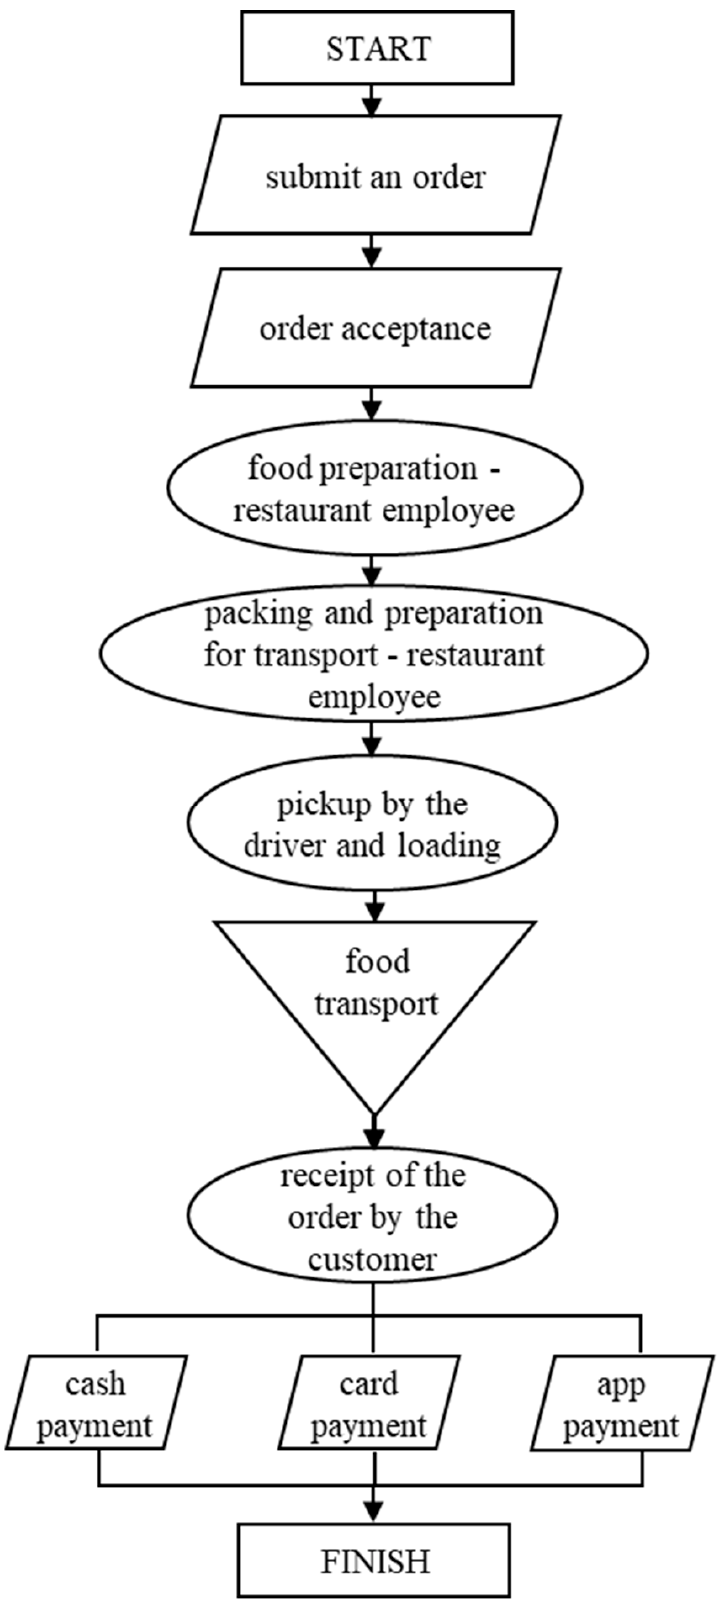
Figure 4. Catering delivery process algorithm in terms of the DHI methodology.